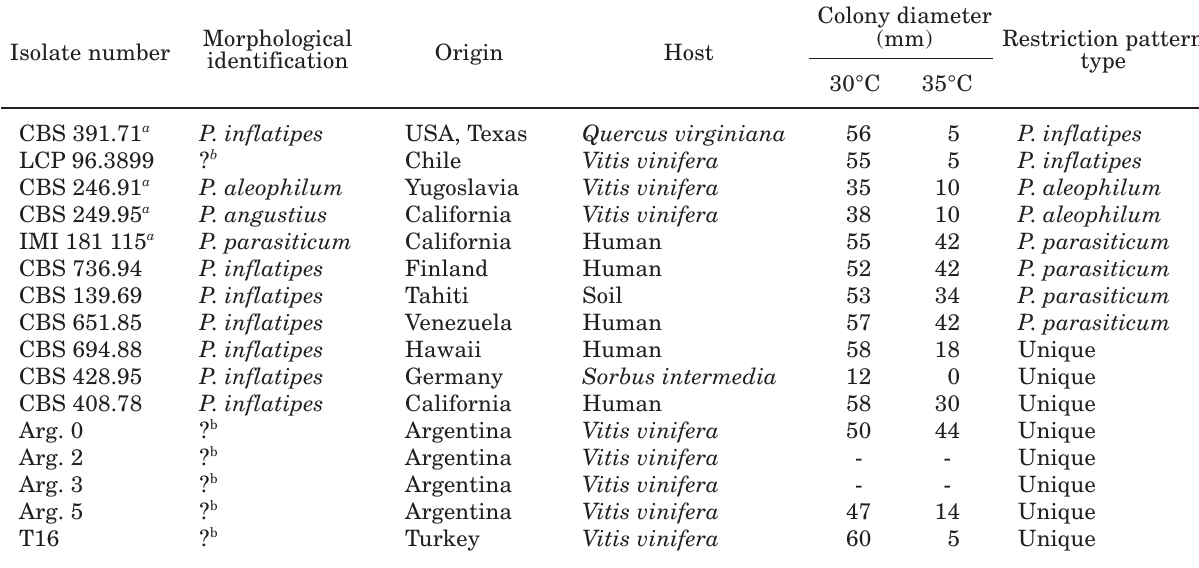
Table 3. Comparison of colony diameters and restriction patterns of 5 unidentified “grey isolates” from grapevines with reference to Phaeoacremonium